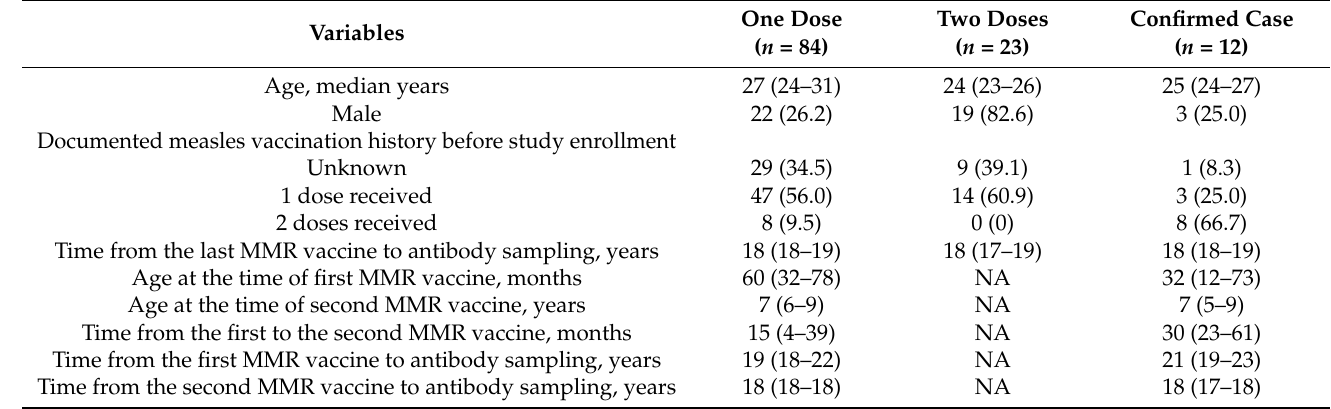
Table 1. Demographic of each cohort of one or two booster doses of MMR vaccine or laboratory- confirmed measles infection among young, seronegative healthcare